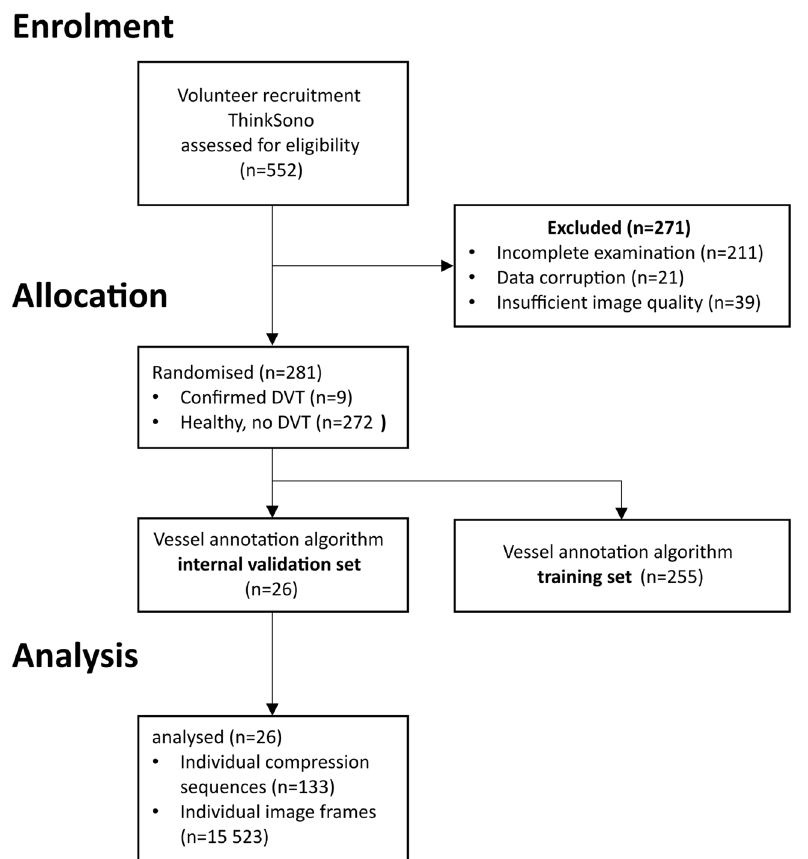
Fig. 7 Consort diagram for inclusion of volunteer scans into the training set and internal validation set. Dataset curation for the training and internal validation data. Our approach can be trained from image data that originates predominantly from healthy